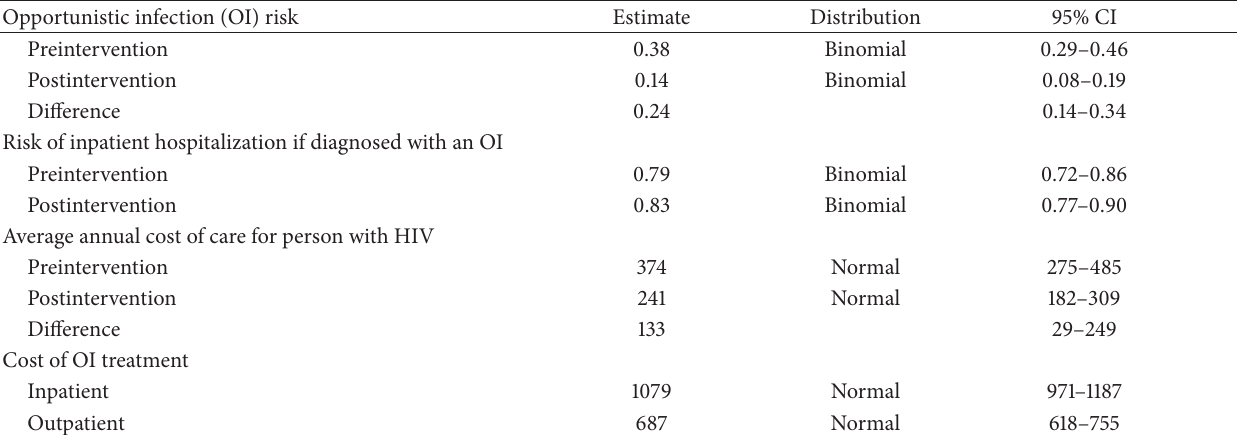
Table 4: Cost-effectiveness analysis model